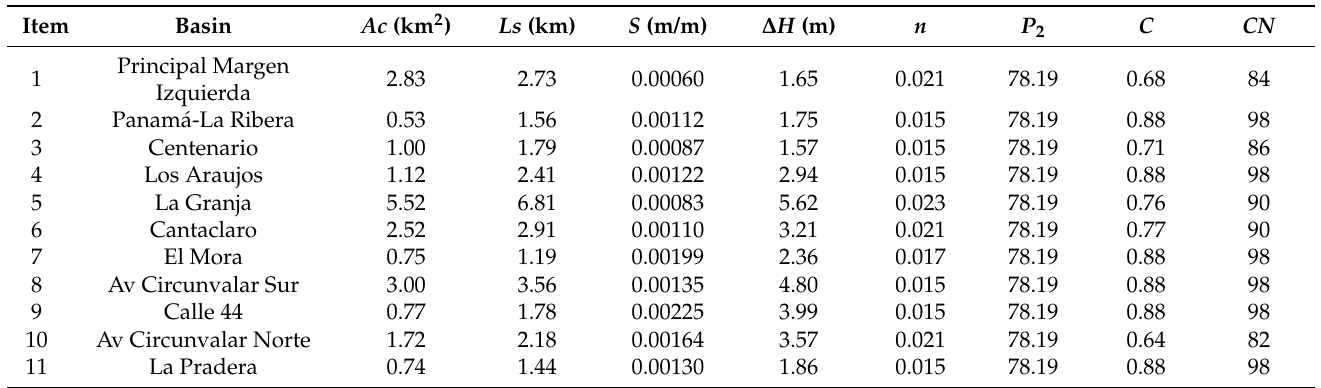
Table 1. Morphometric parameters of the small watersheds of the study and hydraulic parameters of the main